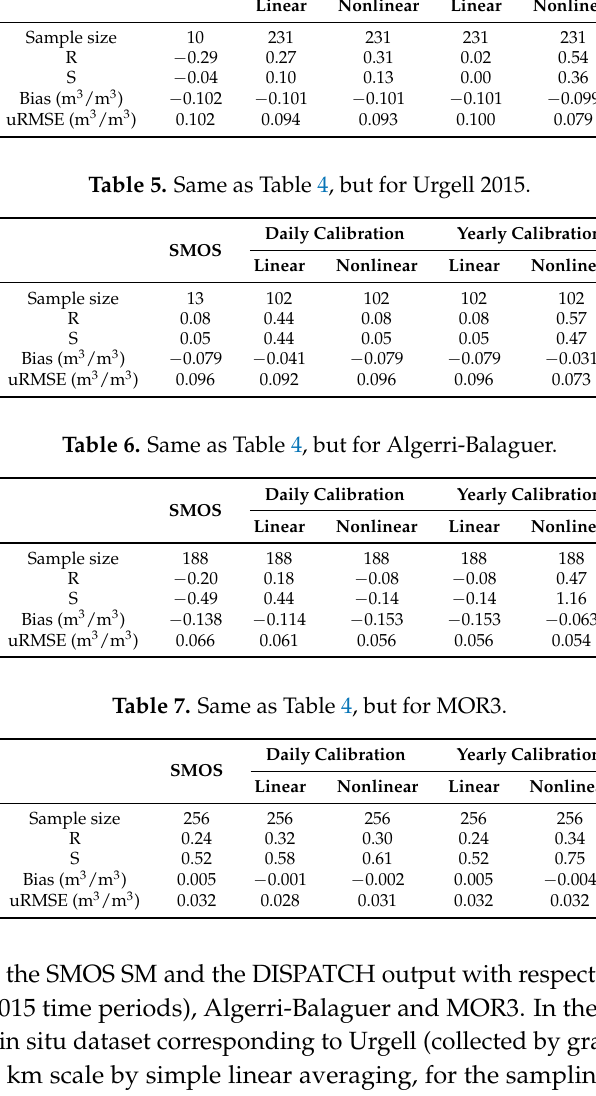
Table 4. Correlation coefficient, slope of the linear regression, bias, unbiased RMSE (uRMSE) between SMOS SM/DISPATCH SM and in situ data are reported, alongside the sample size used in the analysis. DISPATCH is tested with the linear and the nonlinear modes, with the daily and multi-date calibration. Daily Calibration Yearly Calibration SMOS Linear Nonlinear Linear